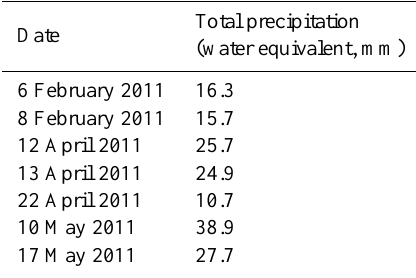
Table 2. Major precipitation events (i.e. greater than 10-mm water equivalent) at the field area during the study period from 1 Novem- ber 2010 to 1 June 2010 based on the Sugarloaf NADP data (NADP site CO94 at 39.99 ◦ N, 105.48 ◦ W; NADP, 2011). All events are snow except for the 17 May 2011 event, which is a rain/snow